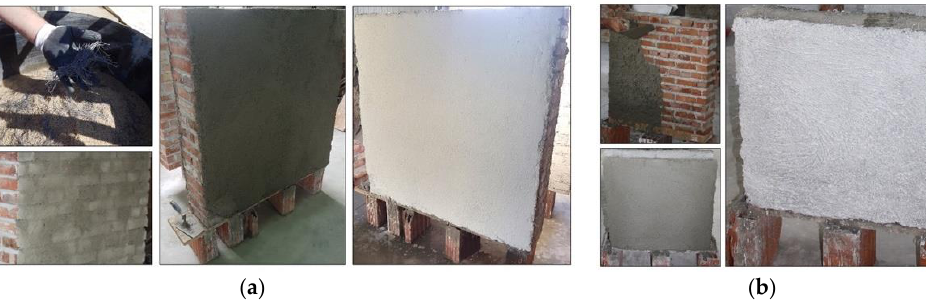
Figure 11. Reinforcement preparation: ( a ) mixing polypropylene fibers with sand and ( b ) application.